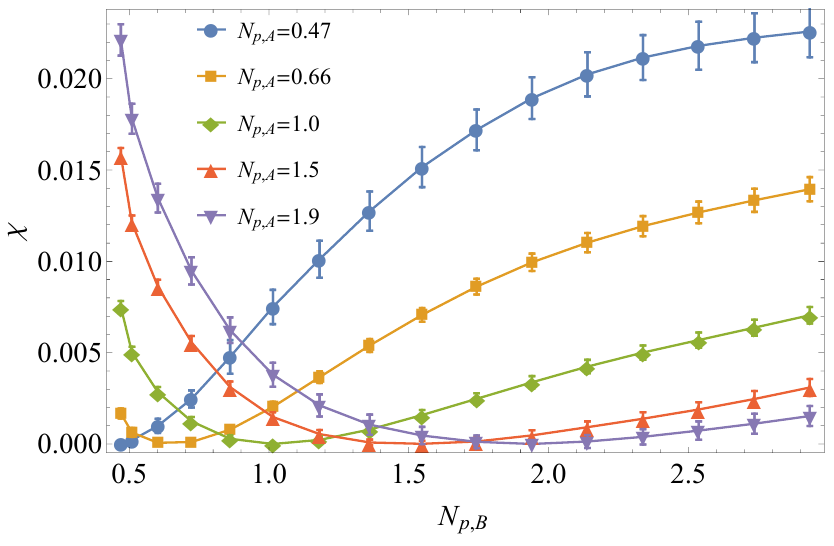
Figure 6. χ per bead as a function of the persistence length of the variable chain, N p , B